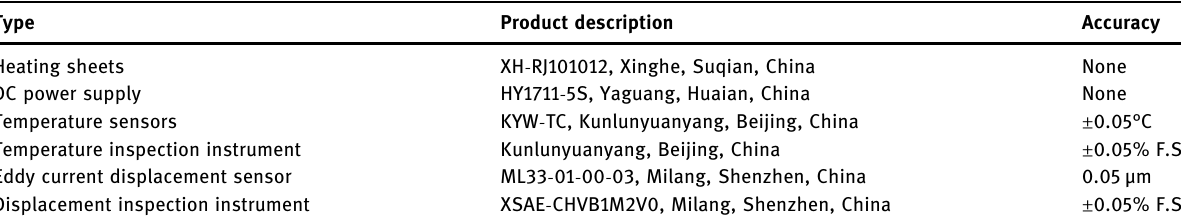
Table 3: Experimental instrument properties